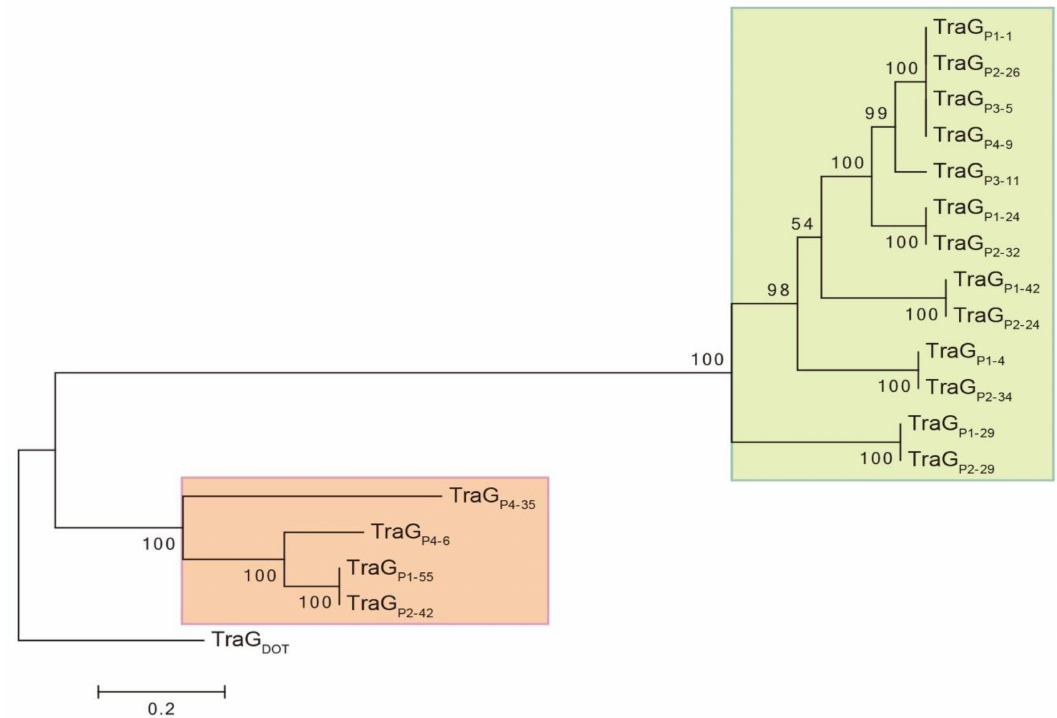
Figure 3. Molecular phylogenetic analysis of TraG proteins of putative conjugative genomic islands (GIs) of Mucilaginibacter . The evolutionary history was inferred by using the Maximum Likelihood method based on the JTT matrix-based model [32]. The percentage of trees in which the associated taxa clustered together is shown next to the branches. The tree is drawn to scale, with branch lengths measured in the number of substitutions per site. Evolutionary analyses were conducted in MEGA6 [28]. Initial alignment of sequences was performed using Muscle for the presented tree. An identical tree with minor changes in bootstrap values was obtained using ClustalW for alignment. The VirB4 subunit of MPFB T4SS is named TraG [41]. For convenience and consistence in TraG protein identification, nomenclature is as follows: TraGPX-Y, where X is the strain number and Y the contig carrying the gene coding for TraG. TraG CTnDOT (TraGDOT) accession number: